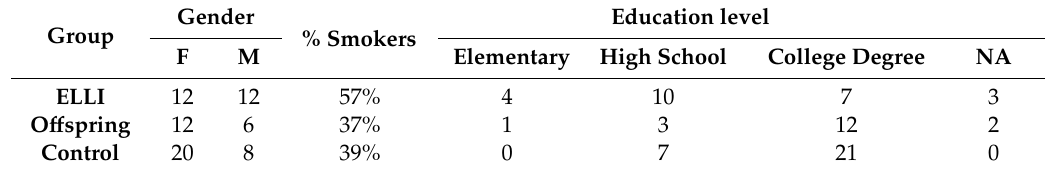
Table A2. IMECS demography.